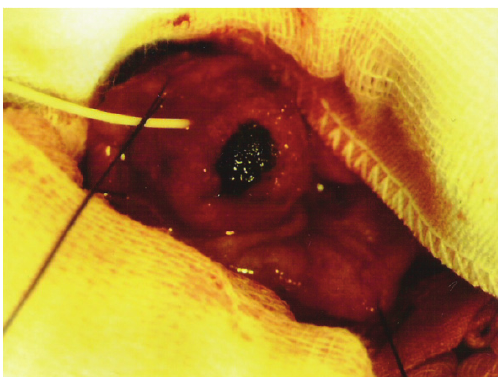
Figure 3- Aspect of the submucosal lesion in the second part of the duodenum after duodenotomy, being approximately 2.5 cm in diameter and having an integral mucosa. The dark area corresponds to the frozen-section biopsy site. A catheter was introduced into the orifice close to the apex of the lesion.